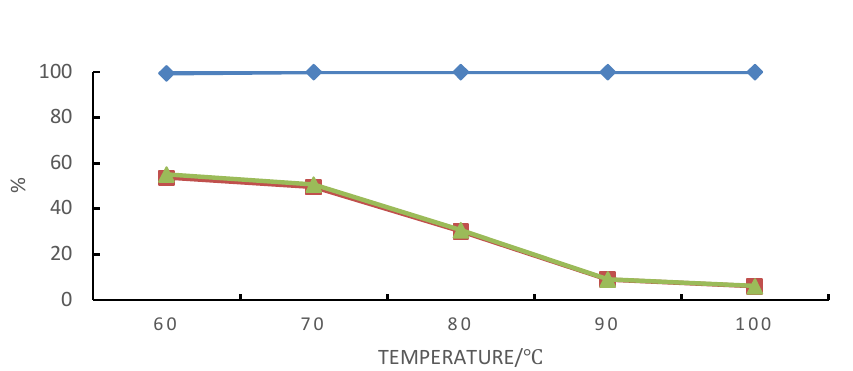
Figure 5. Effect of temperature on the hydration of α -pinene with the following reaction conditions: m( α -pinene)/m(water)/m(acetic acid)/m(citric acid)/m(boric acid) = 10:10:25:1:0.4, 24 h.